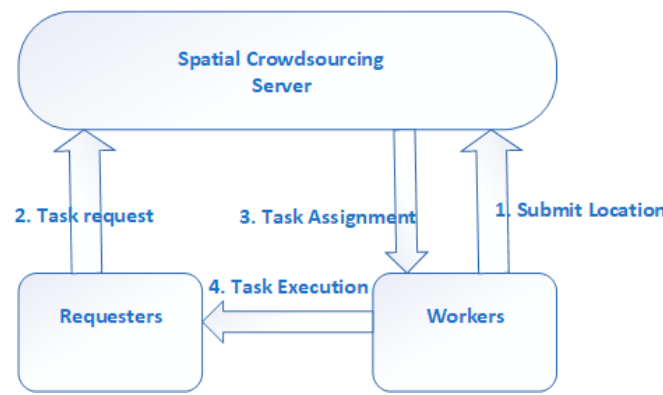
Figure 1. The model of the spatial crowdsourcing (SC) system.